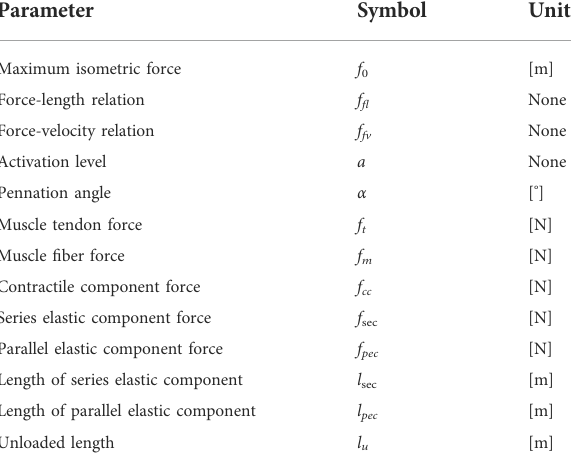
TABLE 1 Parameters in the Hill muscle